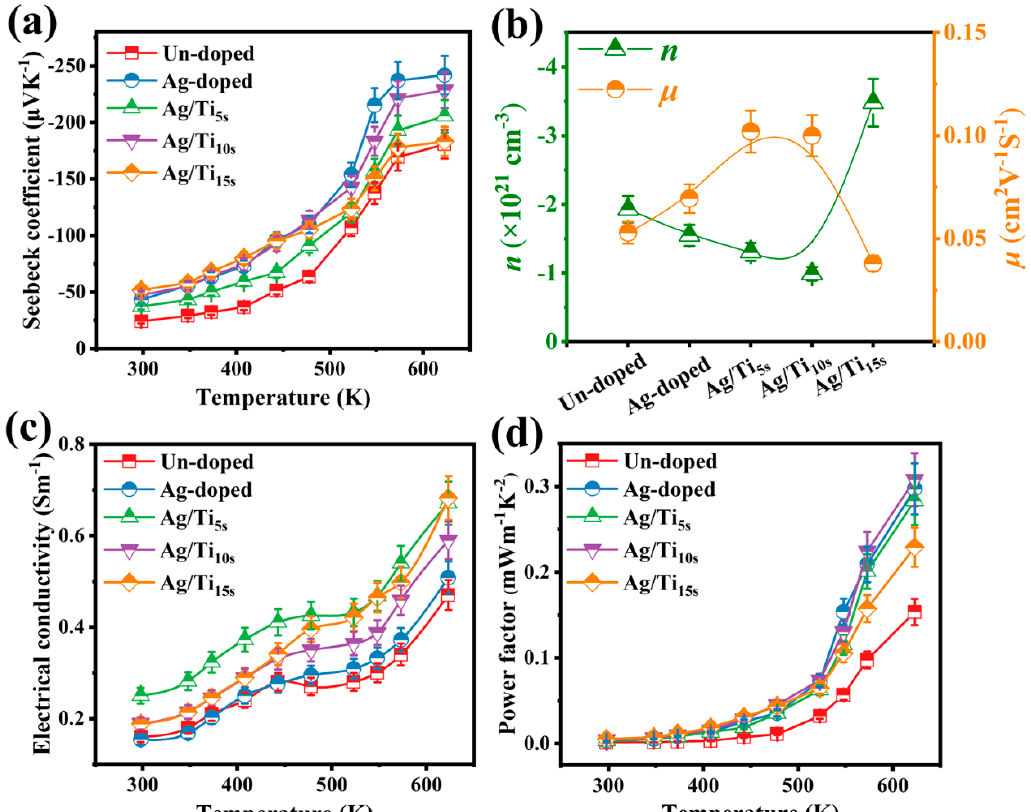
Figure 5. Thermoelectric properties of all the thin films: ( a ) Seebeck coefficient; ( b ) Carrier concentration and mobility; ( c ) Electrical conductivity; ( d ) Power factor from 273 K to 623 K.